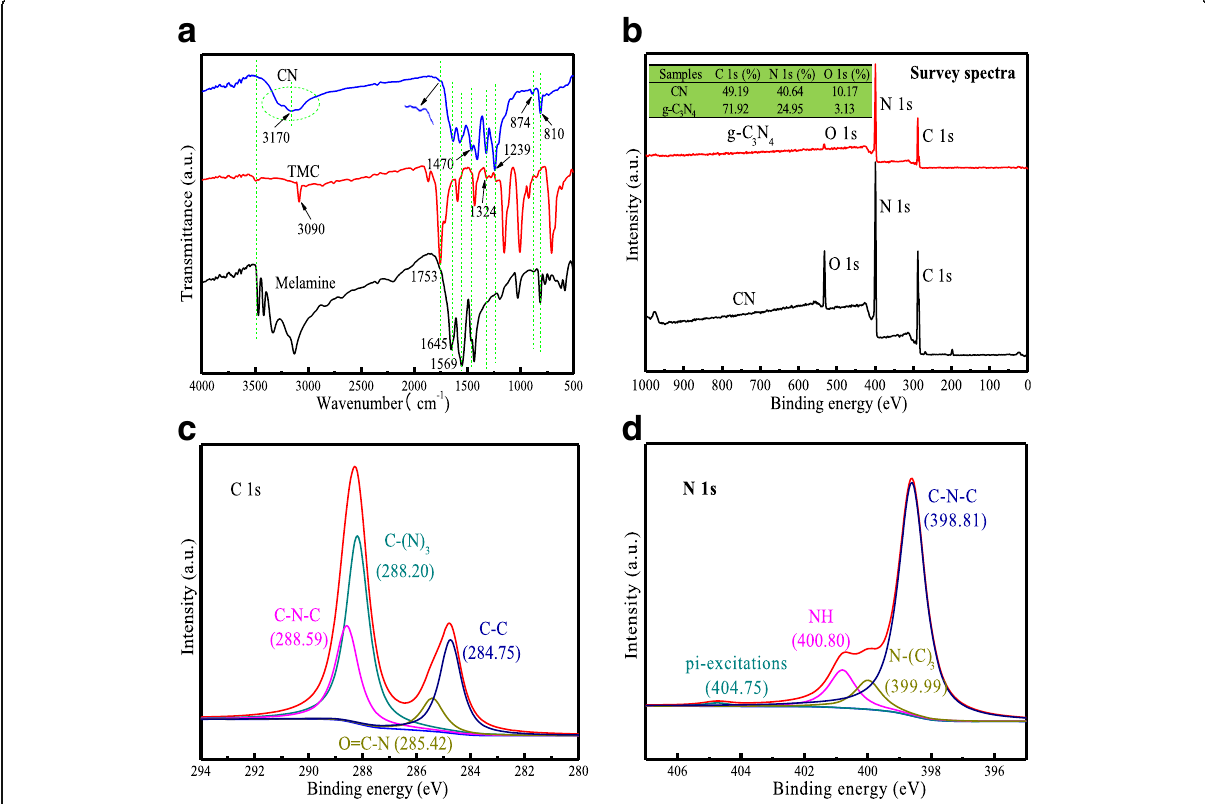
Fig. 1 a FT-IR spectra, b XPS survey spectrum, the high-resolution scan of c C1s and d N1s of CN